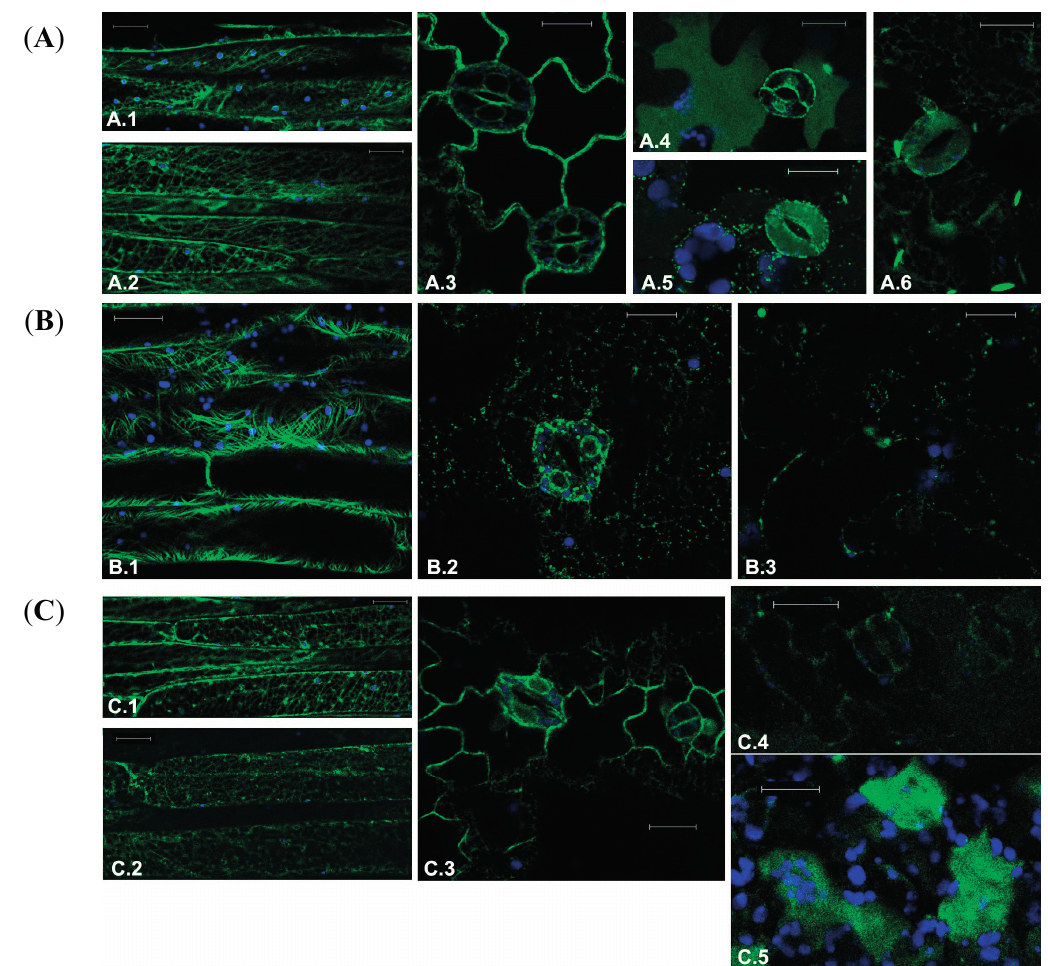
Figure 1. Fluorescent patterns of GFP-tagged marker proteins in transgenic Arabidopsis tissues in control conditions or treated with drugs targeting the cytoskeleton. ( A ) Normal fluorescent pattern of transgenes of ( A.1 ) and ( A.2 ) microtubules marker GFP-TUA6 in elongated petiole cells; ( A.3 ) ER marker GFPKDEL in leaf epidermal cells; ( A.4 ) Marker of the lytic vacuole, AleuGFP, in the lower face of the leaf; ( A.5 ) AleuGFP, in the upper face of the leaf; and ( A.6 ) Vacuolar marker characteristic of the direct transport ER-to-vacuole GFPChi; ( B ) Effect of treatment with 30 μ M Paclitaxel on fluorescent pattern of ( B.1 ) GFP-TUA6 in petiole cells; ( B.2 ) GFPKDEL in leaf epidermis; ( B.3 ) GFPChi in leaf epidermis; and ( C ) Effect of treatment with 200 μ M Y-27632 on fluorescent pattern of ( C.1 ) GFP-TUA6 in petiole cells showing no significant alteration; ( C.2 ) GFP-TUA6 showing stronger effects; ( C.3 ) GFPKDEL in leaf epidermis; ( C.4 ) GFPChi faint fluorescence in leaf epidermis; and ( C.5 ) GFPChi fluorescence secreted in the intercellular spaces of leaf mesophyll. GFP fluorescence and chlorophyll autofluorescence are shown in green and blue, respectively. Scale bar = 20 μ